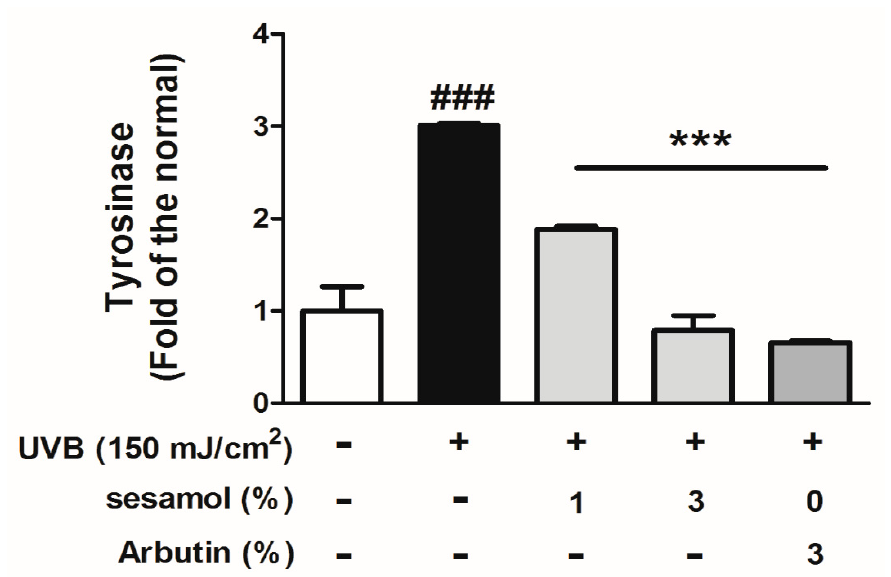
Figure 9. Light micrographs of histological sections stained with antibodies against tyrosinase in UVB-irradiated C57BL/6 mice that received topical application of sesamol once a day to the ear skin. The tyrosinase level increased in the UVB-irradiated group, whereas topical application of sesamol reduced the effect. (Significant difference versus control: ###, p < 0.001. Significant difference versus UVB treated group: ***, p < 0.001.).